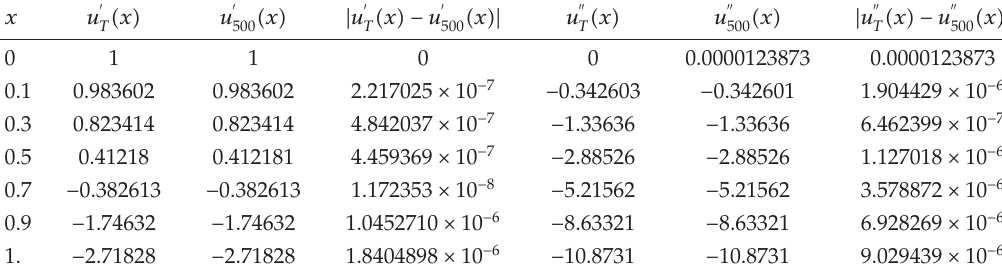
Table 2: The numerical results of Example 3.1.